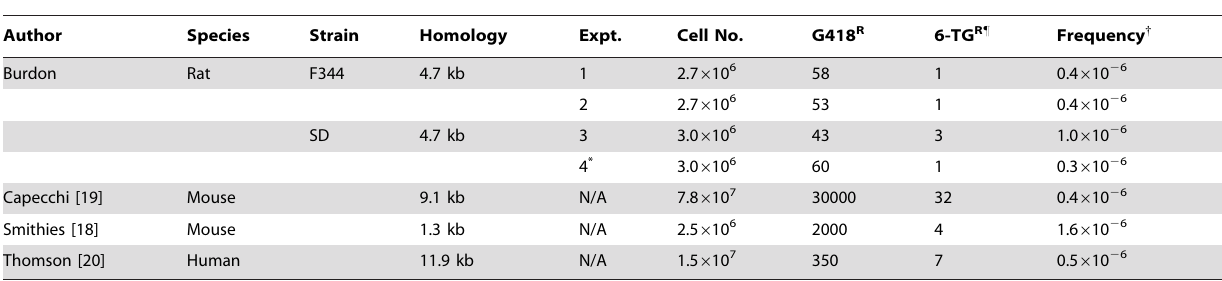
Table 3. Comparison of HPRT targeting frequency in ES cells.